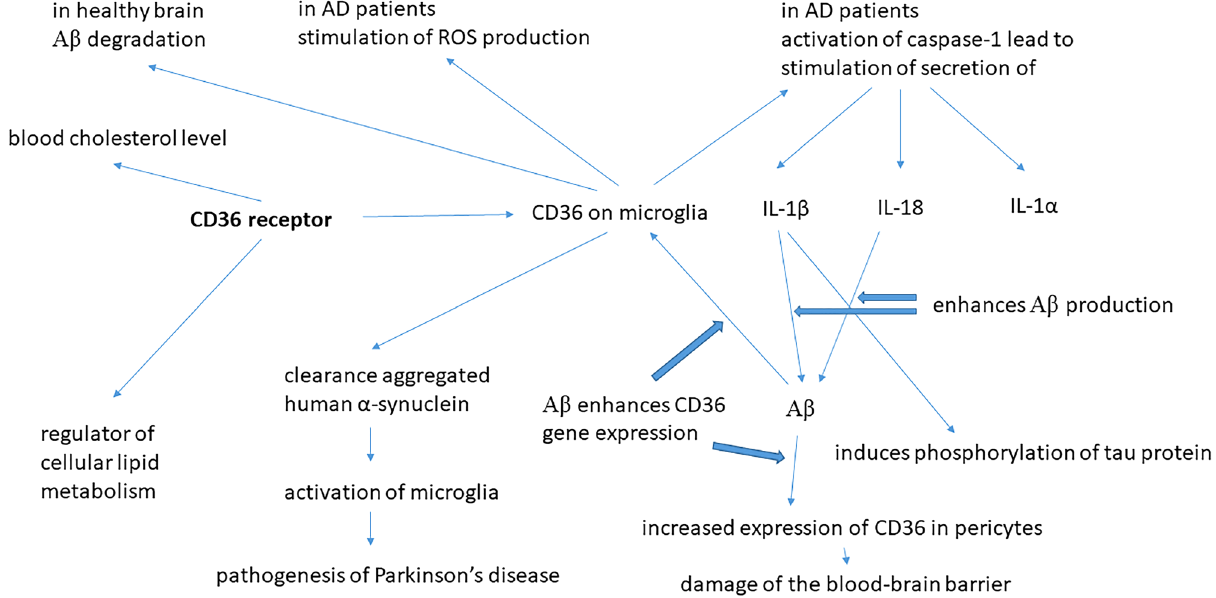
Figure 5. Some roles of the CD36 receptor in the pathogenesis of Alzheimer’s disease and Parkinson’s